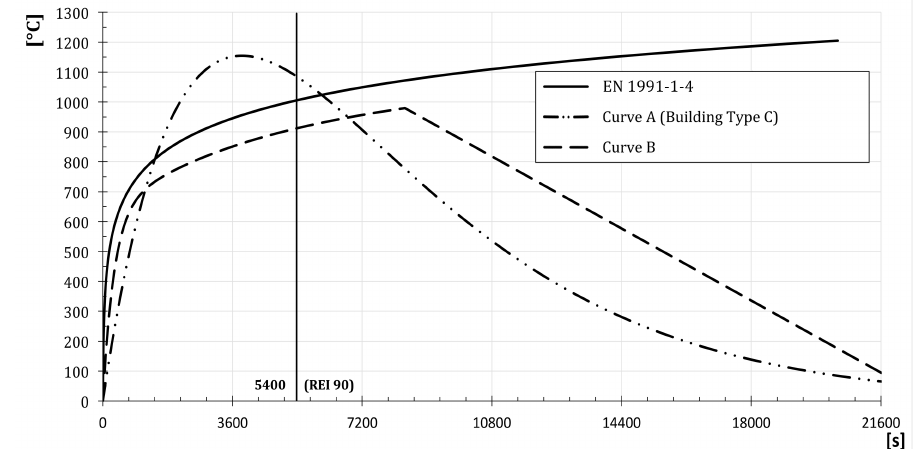
Figure 2. Trend of the temperatures with respect to time (q = 233.6 MJ m − 2 ; O = 0.0289 m 0.5 ) based on the prescriptive approach (EN 1991-1-2) and the simplified performance-based models (Equation (3)): “Curve A with a building of the type C”; Equation (6) “Curve B”), with a specific focus on the time concerning the structures REI 90.